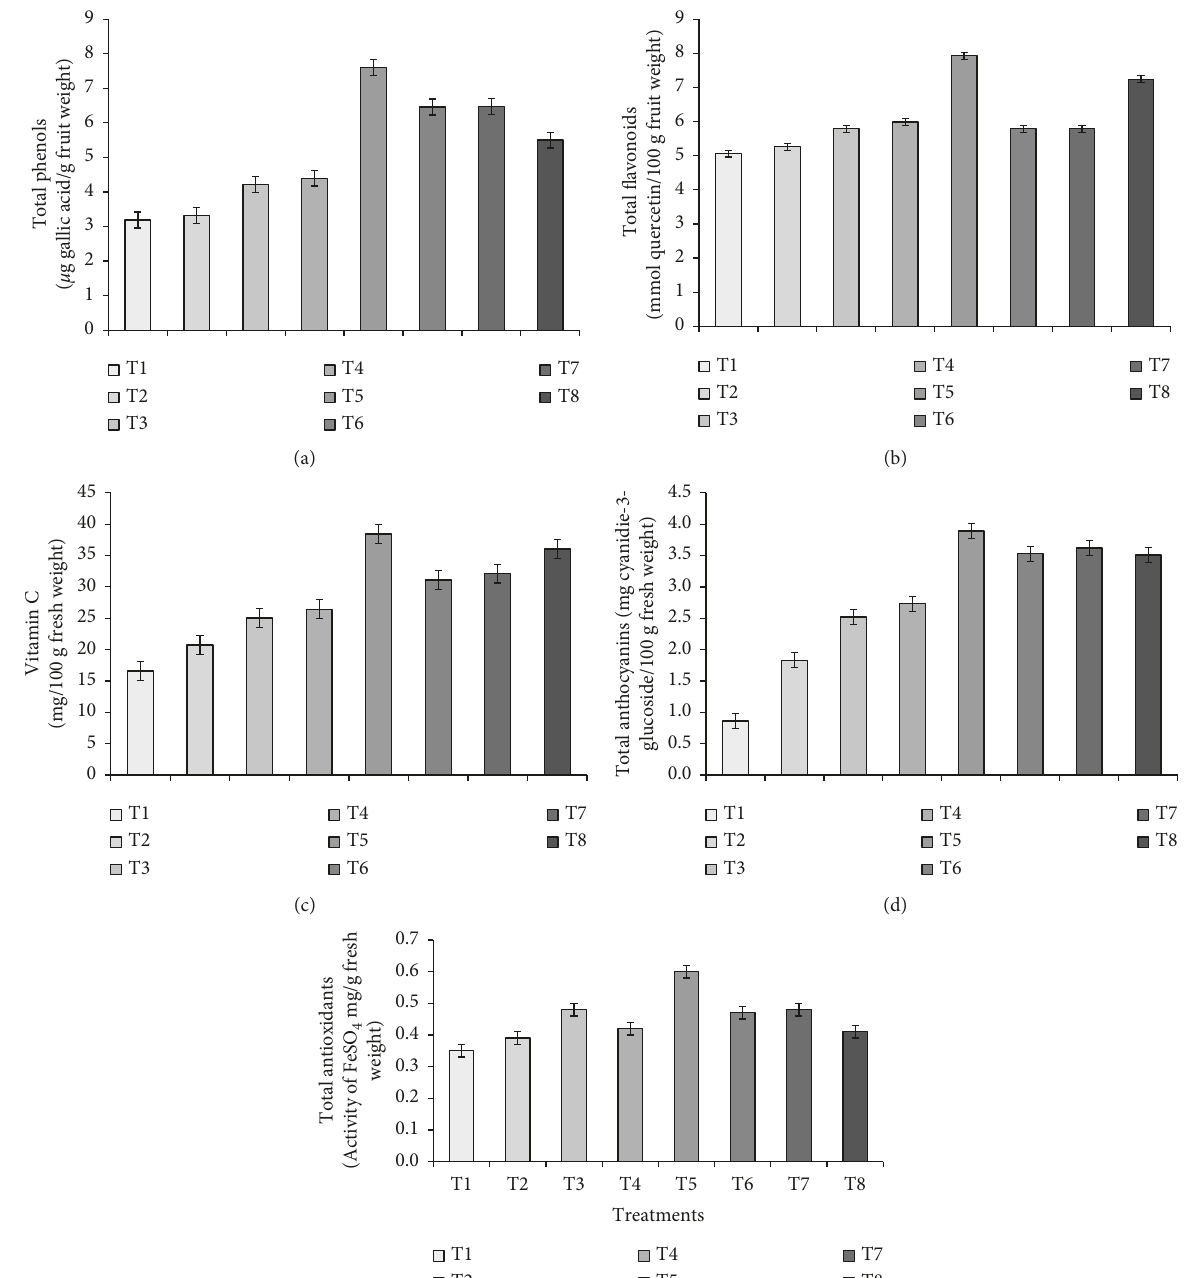
Figure 5: Influence of different organic and inorganic fertilizer regimes on (a) total phenols ( μ g gallic acid/g fruit weight), (b) total flavonoids (mmol quercetin/100g fruit weight), (c) vitamin C (mg/100 g fresh weight), (d) total anthocyanins (mg cyanidin-3-glucoside/ 100g fresh weight), and (e) total antioxidants (activity of FeSO4 mg/g fresh weight) of strawberry cv. Chandler. T1: control; T2: urea 150kg N per ha; T3: FYM equivalent to 150kg N per ha; T4: PM equivalent to 150kg N per ha; T5: FYM equivalent to 75 kg N per ha+PM equivalent to 75kg N per ha; T6: FYM equivalent to 75kg N per ha+urea equivalent to 75 kg N per ha; T7: PM equivalent to 75kg N per ha+urea equivalent to 75kg N per ha; T8: FYM equivalent to 50kg N per ha+PM equivalent to 50kg N per ha+ urea 50 kg N per ha.